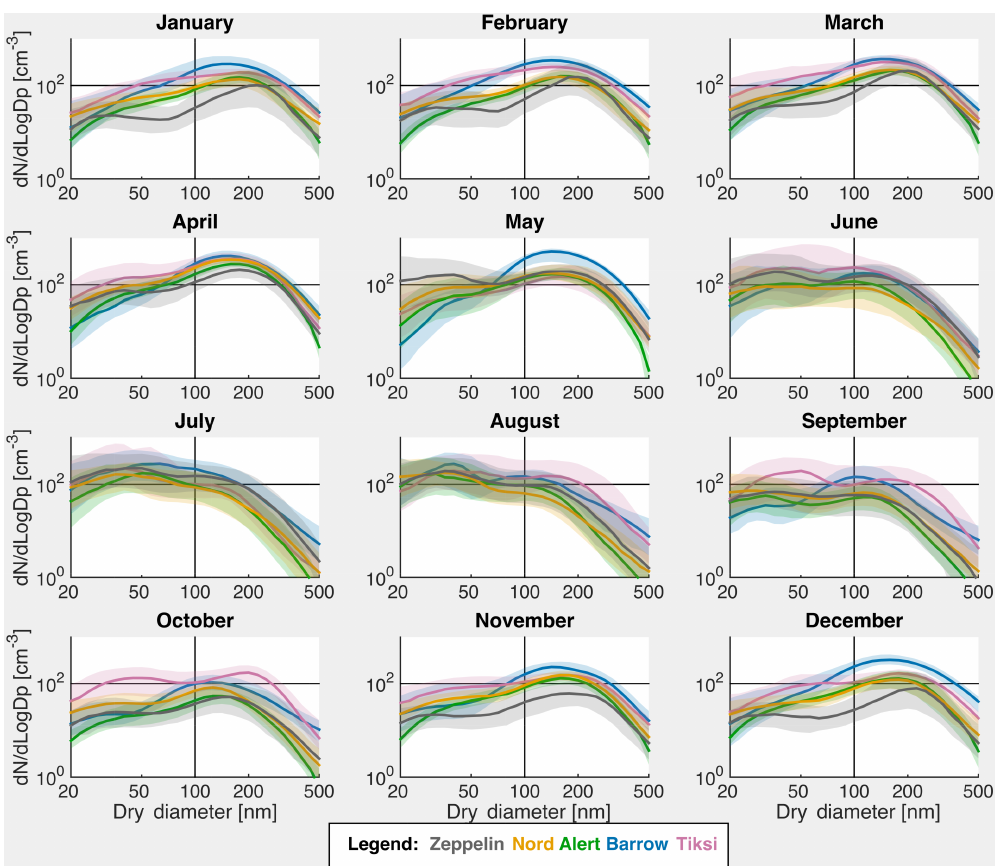
Figure 4. The monthly aerosol number size distributions. The solid curves indicate the median distributions of the 29-bin homogenized dataset, for each of the sites, with the colours matching the colours of the station name in the legend. The shaded semi-transparent areas denote the interquartile range and imply the variability in the aerosol number size distribution is each of the months. The horizontal and vertical black lines at 100cm − 3 and 100nm, respectively, are guidelines for facilitating the comparison between the months. The fitting parameters for approximating these aerosol spectra as the sum of three log-normal distributions are given in Appendix